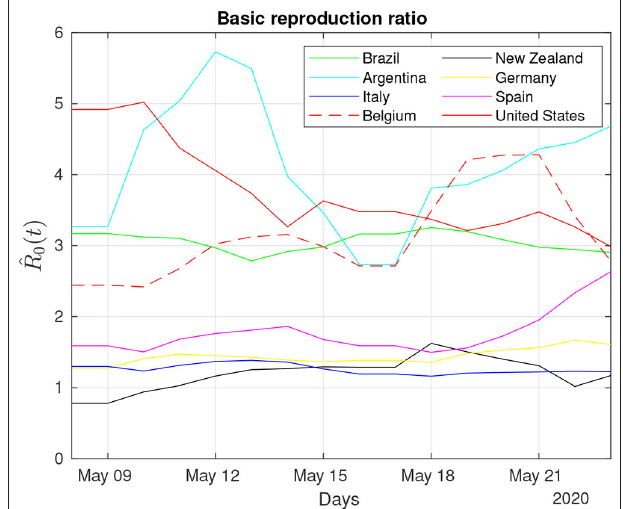
FIGURE 4 | Estimation (dotted lines) of infected individuals (continuous lines) using the recursive least-squares (RLS) technique (the U.S. data was downscaled four times to fit in the graph).